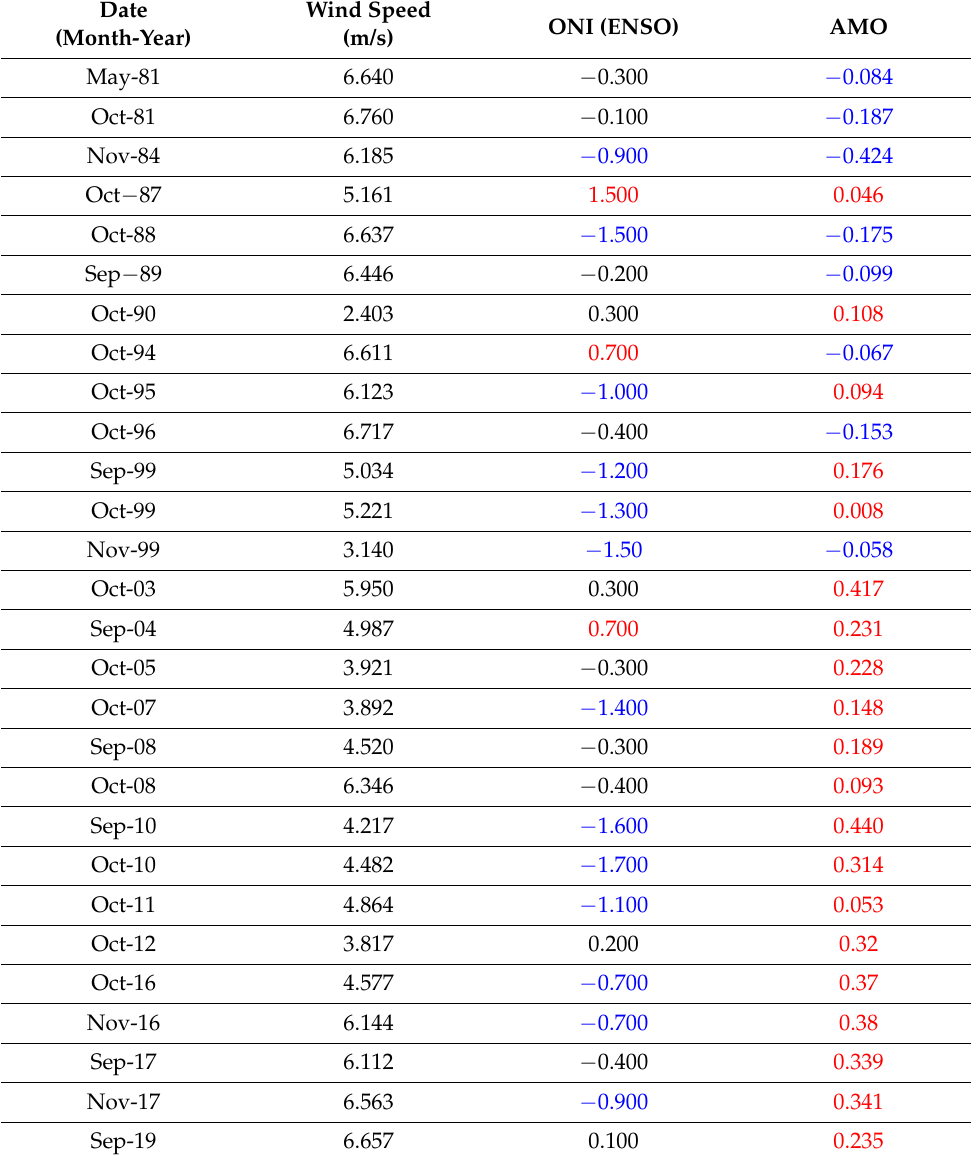
Table 1. Lowest wind speeds registered between 1980–2019 retrieved from the second q1 of CDF. Blue and red colors represent a negative and positive phase of the event